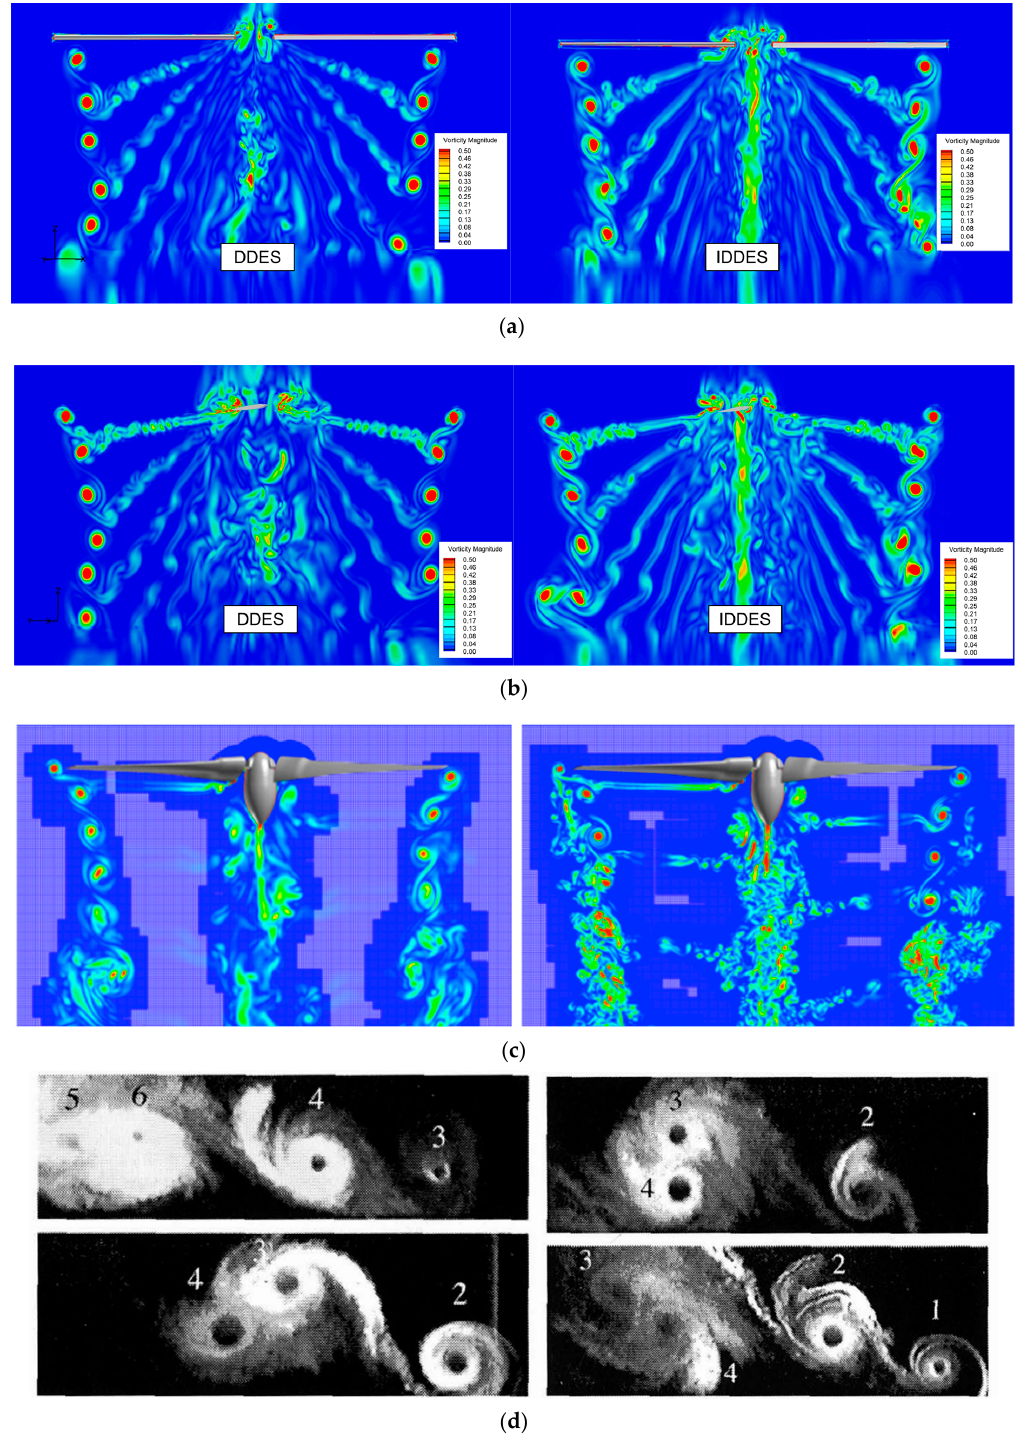
Figure 20. Comparison of cross-section vorticity distribution obtained by DDES and IDDES. ( a ) Y = 0 section, ( b ) X = 0 section, ( c ) DES result with adaptive mesh refinement in Ref. [25], ( d ) Experiment result of vortex pairing in Ref [41].